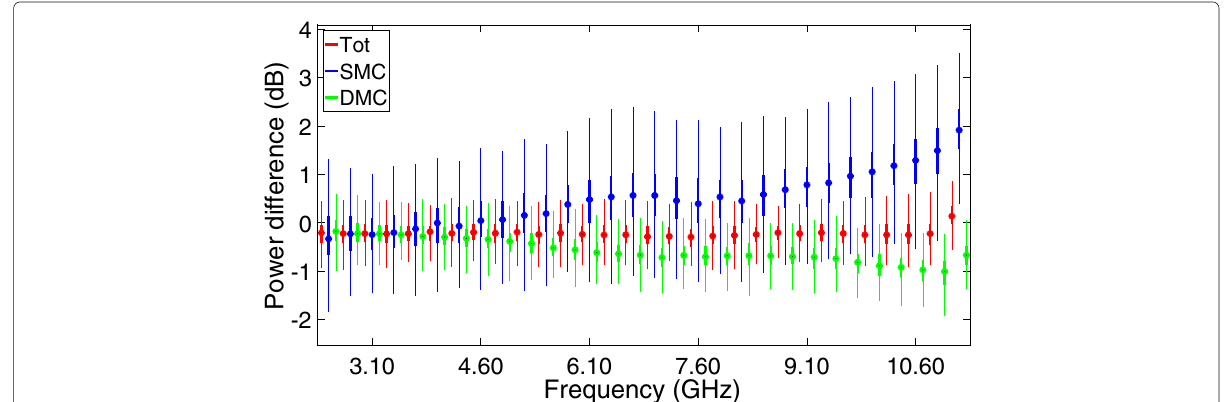
Fig. 9 Box plot of the differences between the input and output powers for the total channel, as well as the contributions of both the SMC and DMC